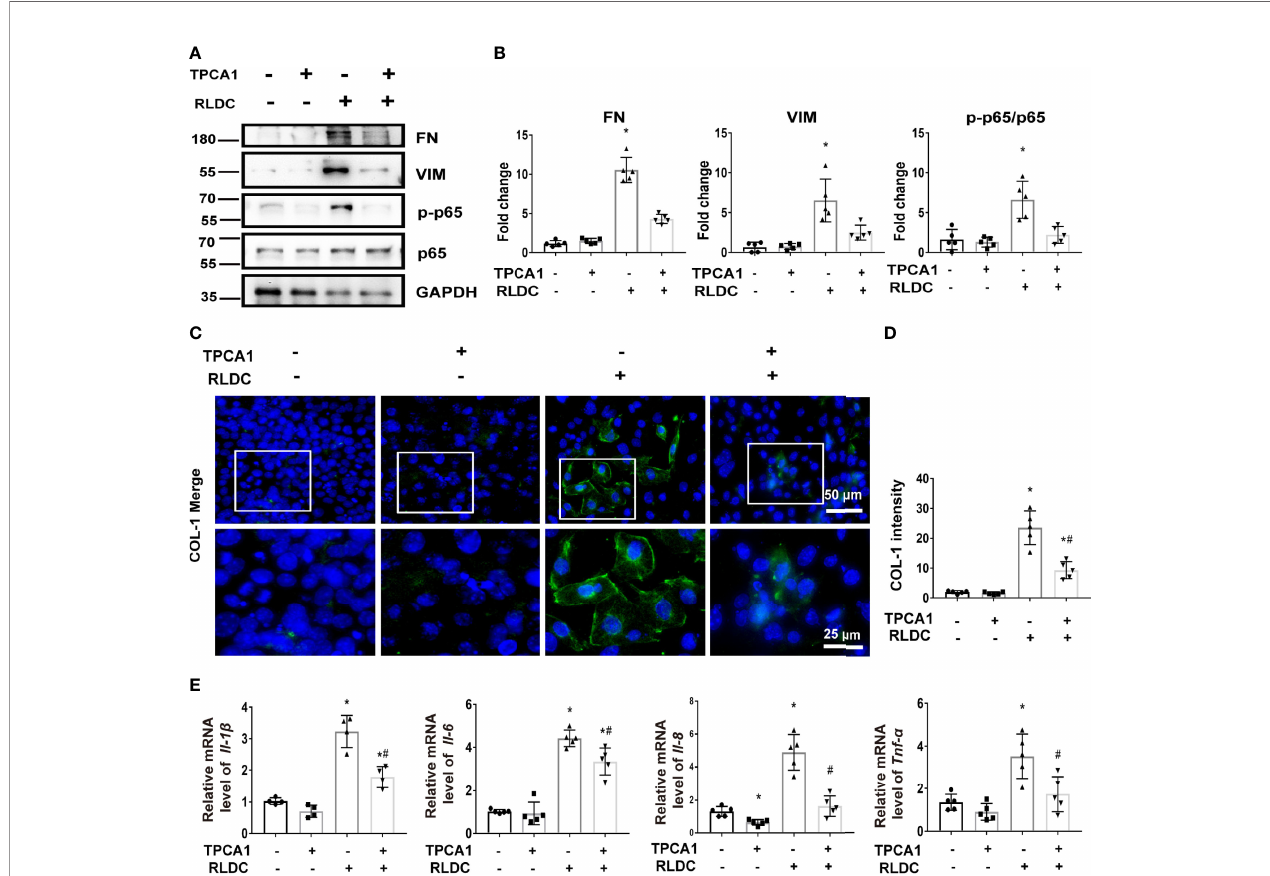
FIGURE 2 | TPCA-1 reduces the expression of pro-in fl ammatory cytokines and fi brotic phenotypes in RLDC-treated renal tubular cells. BUMPT cells were incubated with 2 m M cisplatin for 7h each day for 4 days. After the fi nal dose, RLDC cells were treated with 100 m M TPCA1 or saline for 17h to collect samples. (A) Representative immunoblots of FN, VIM, p-p65, p65 and GAPDH (loading control) of total cellular proteins after RLDC and TPCA1 treatment (n=5). (B) Densitometry of FN, VIM, p-p65, p65. The protein level of control group (TPCA1- RLDC-) was arbitrarily set as 1, and the signals of other conditions were normalized with the control group to indicate their protein fold changes. (C) Immuno fl uorescence analysis of COL-1. (n=5). The images at the bottom are magni fi ed from the boxed area. (D) The quanti fi cation of COL1-1 intensity. (E) mRNA expression of Il-1 b , Il-6, Il-8, Tnf- a (n=5). Data are normalized to GAPDH and expressed as fold change compared to controls. Data are expressed as mean ± SEM. * P <0.05 vs . the control (TPCA1- RLDC-) group, # P < 0.05 vs . (TPCA1- RLDC+)